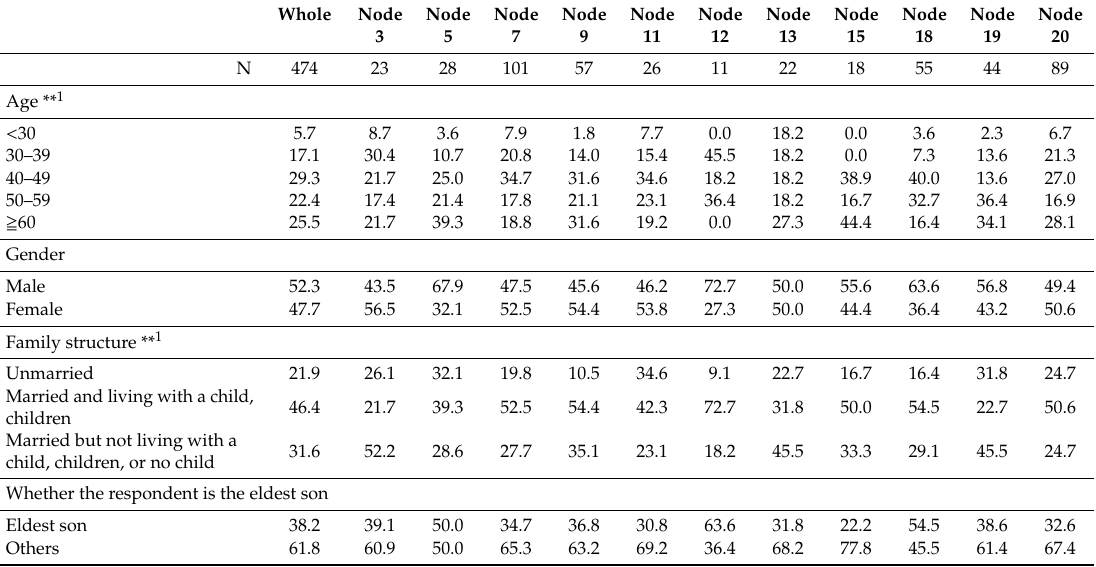
Table 6. The distribution ratio of the demographic characteristics of individuals in each